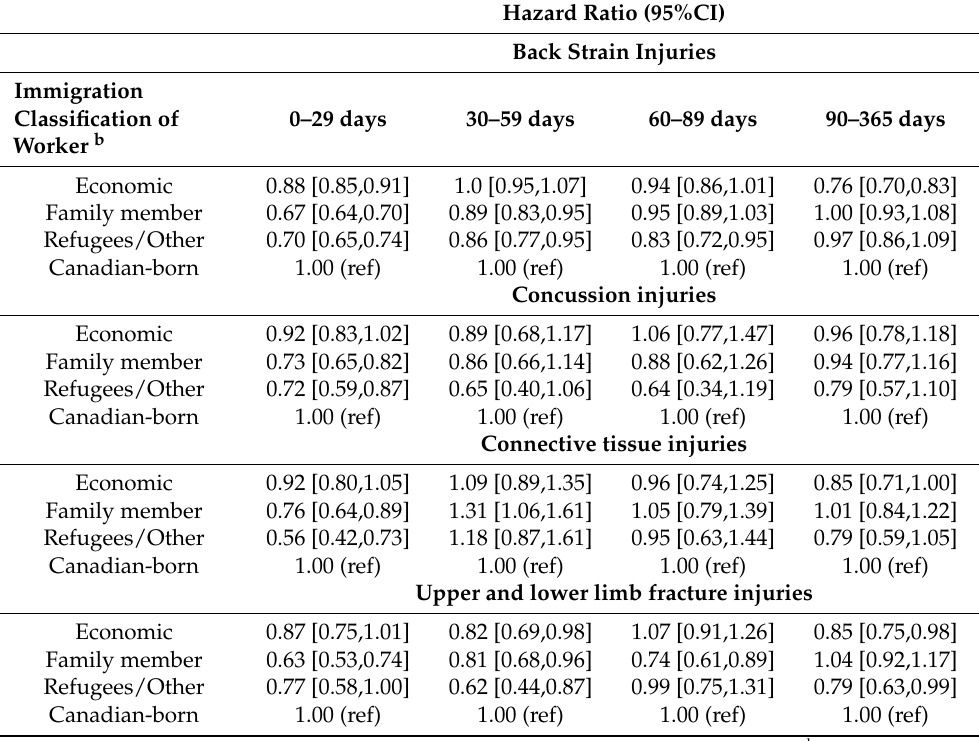
Table 3. Likelihood to sustainable return to work for injured workers on a workers’ compensation claim, by immigration classification, injury type and time period from start of work disability benefits a